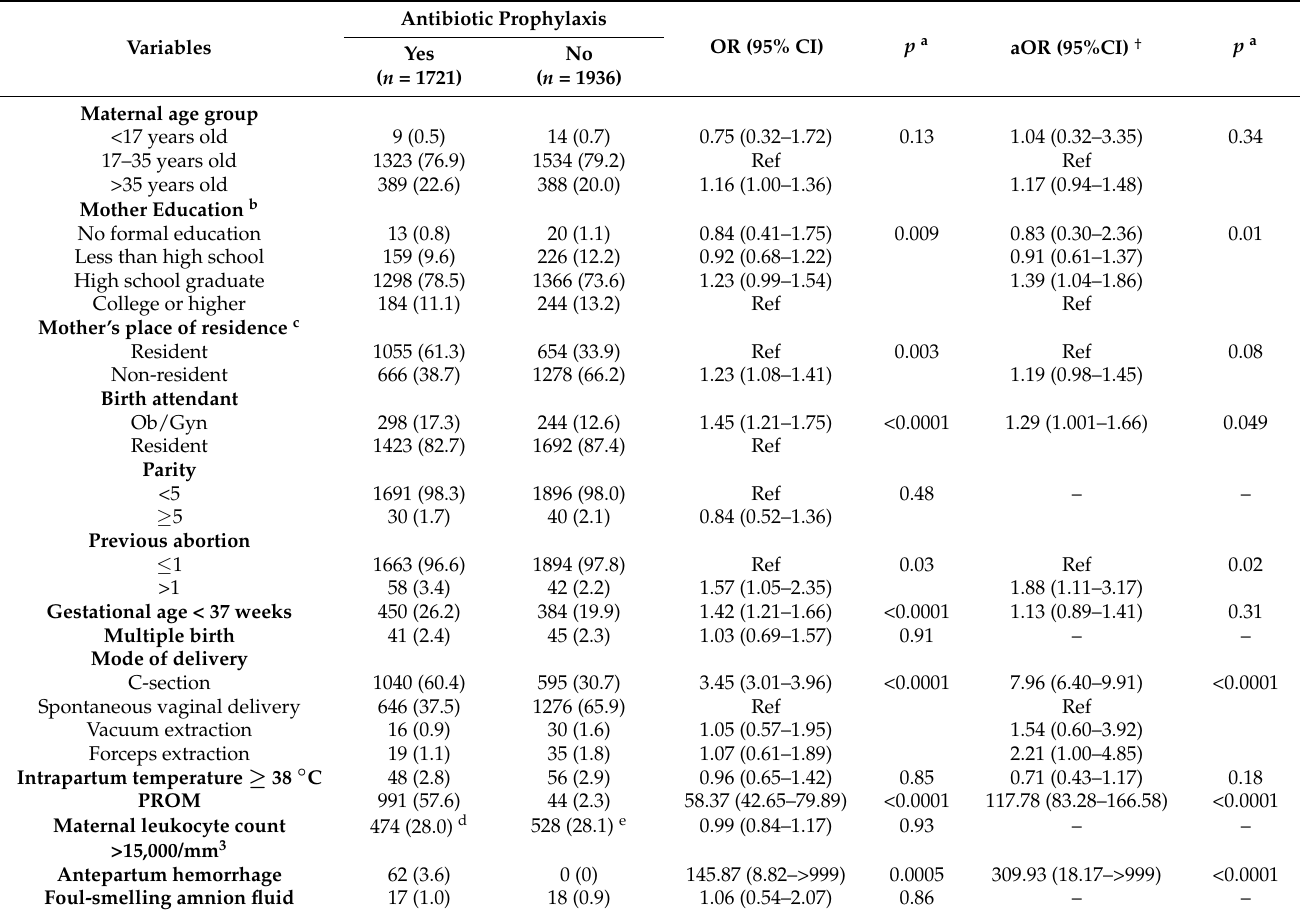
Table 2. Association between prophylactic antibiotic use and maternal sociodemographic and obstetric factors.